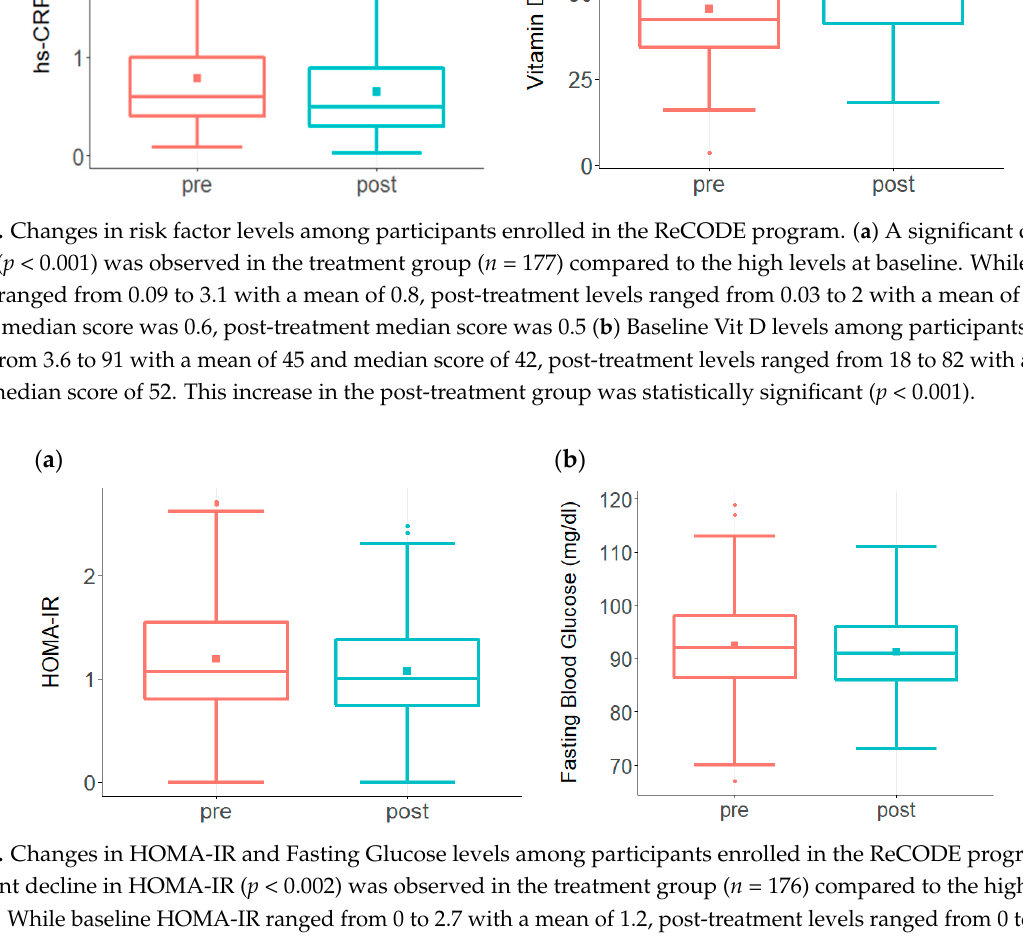
Figure 1. Changes in risk factor levels among participants enrolled in the ReCODE program. ( a ) A significant decline in hs-CRP ( p < 0.001) was observed in the treatment group ( n = 177) compared to the high levels at baseline. While baseline hs-CRP ranged from 0.09 to 3.1 with a mean of 0.8, post-treatment levels ranged from 0.03 to 2 with a mean of 0.64. The baseline median score was 0.6, post-treatment median score was 0.5 ( b ) Baseline Vit D levels among participants ( n = 207) ranged from 3.6 to 91 with a mean of 45 and median score of 42, post-treatment levels ranged from 18 to 82 with a mean of 50 and median score of 52. This increase in the post-treatment group was statistically significant ( p < 0.001).